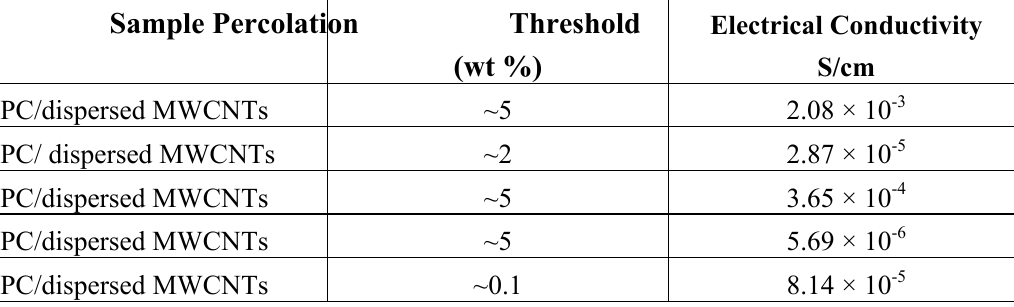
Table 4. Electrical Conductivity of Polycarbonate (PC)/MWCNTs